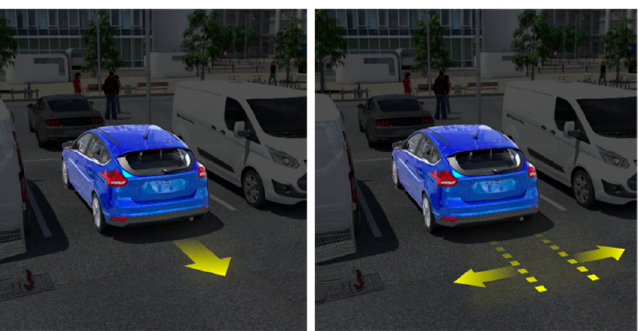
Figure 4. Graphics from a Visual Design Preference item. Each item’s question read: “You are a pe- destrian walking through a parking lot. A parked autonomous car has shifted into reverse. Which projected graphic do you think communicates this best?”.